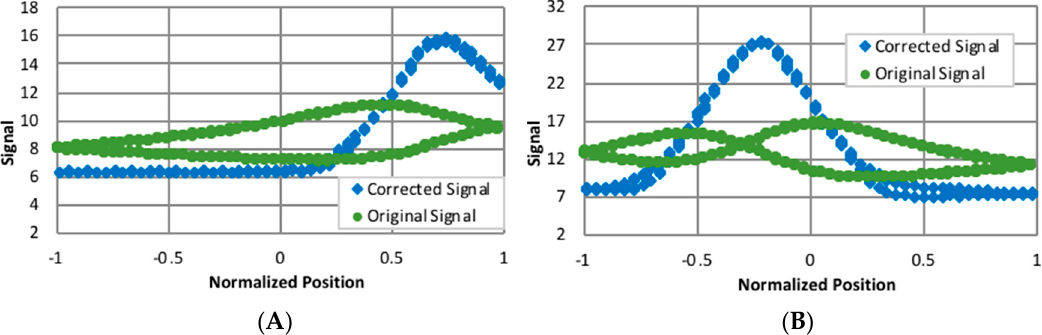
Figure 16. Uncorrected and corrected signals (V) for a laterally moving paper target for ( A ) channel 2 and ( B ) channel 3 of the sensor.